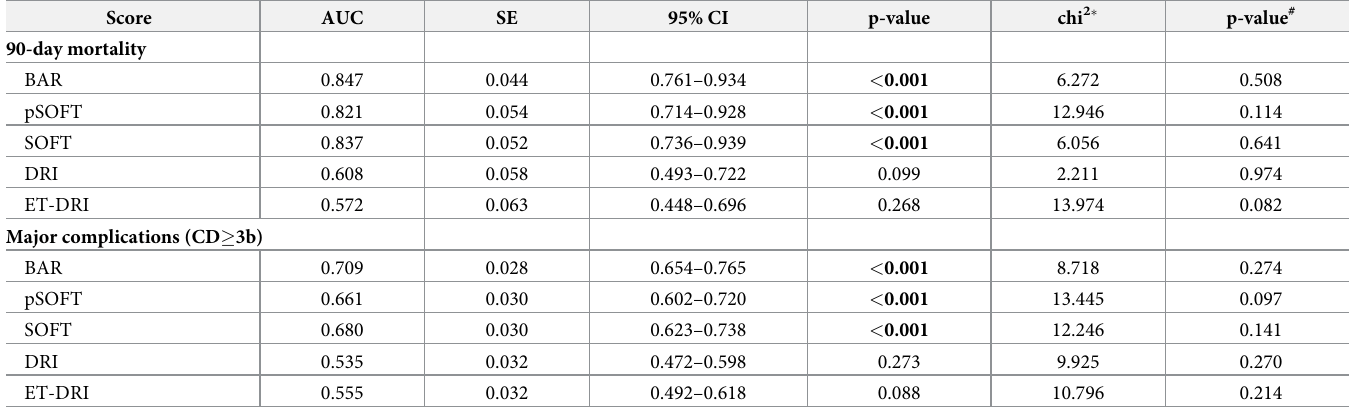
Table 4. AUROC analysis and goodness-of-fit testing for the various scores based on 90-day mortality and major complications (CD � 3b).